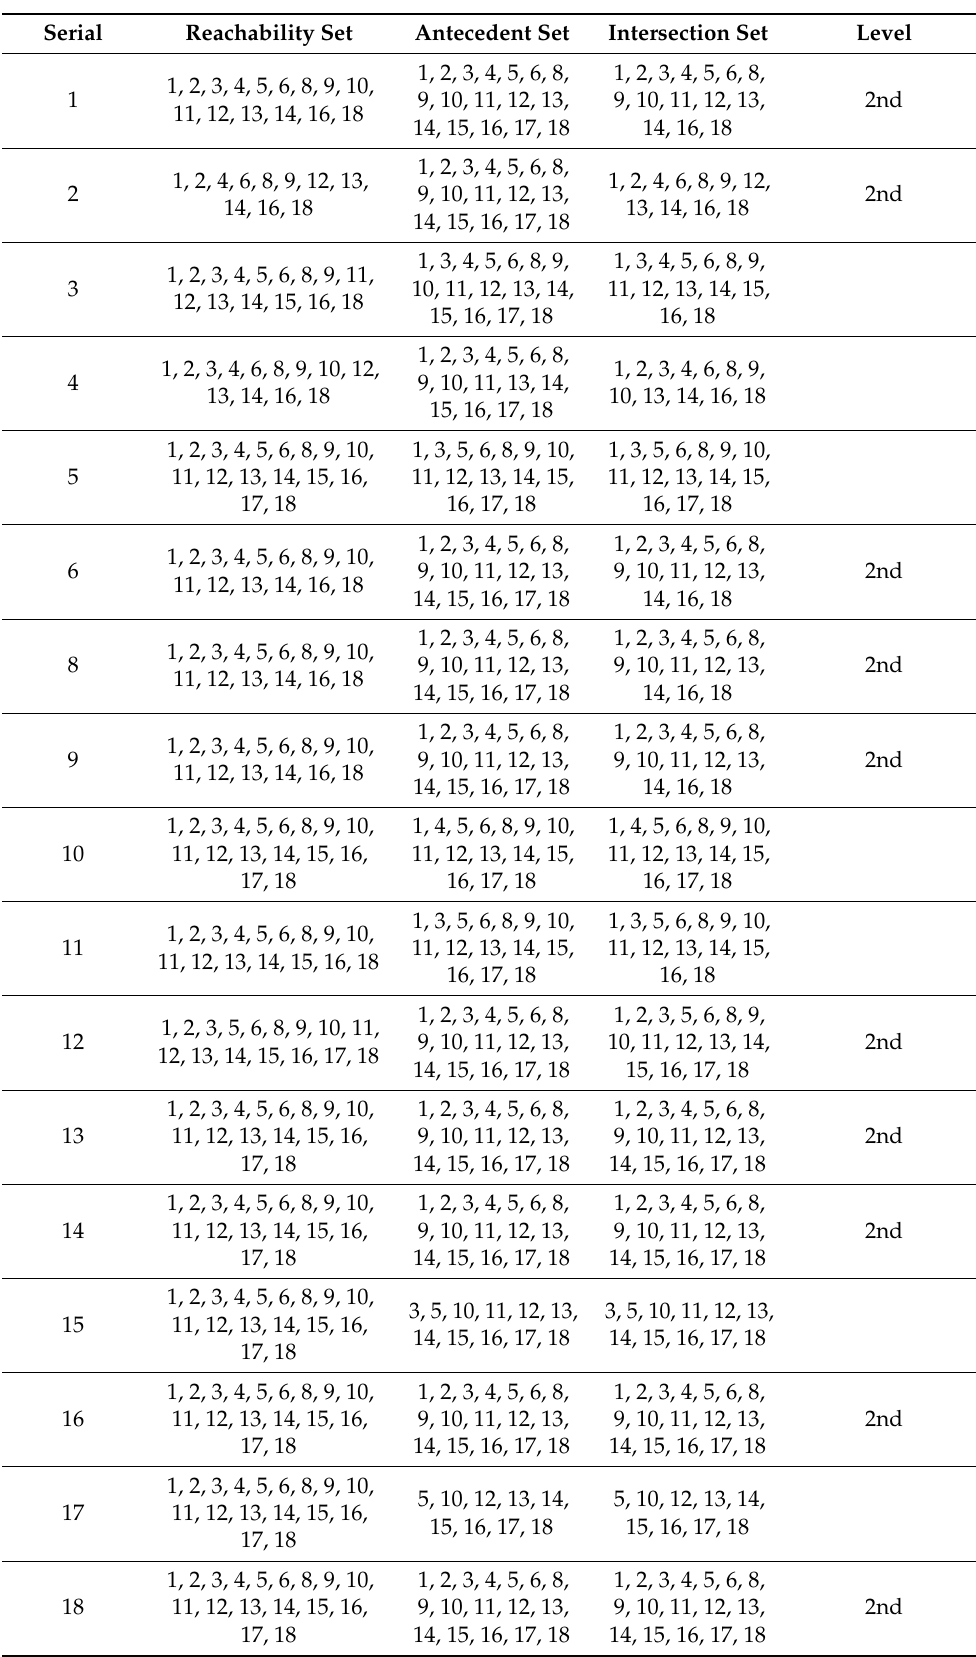
Table A2. Level partitioning (Level